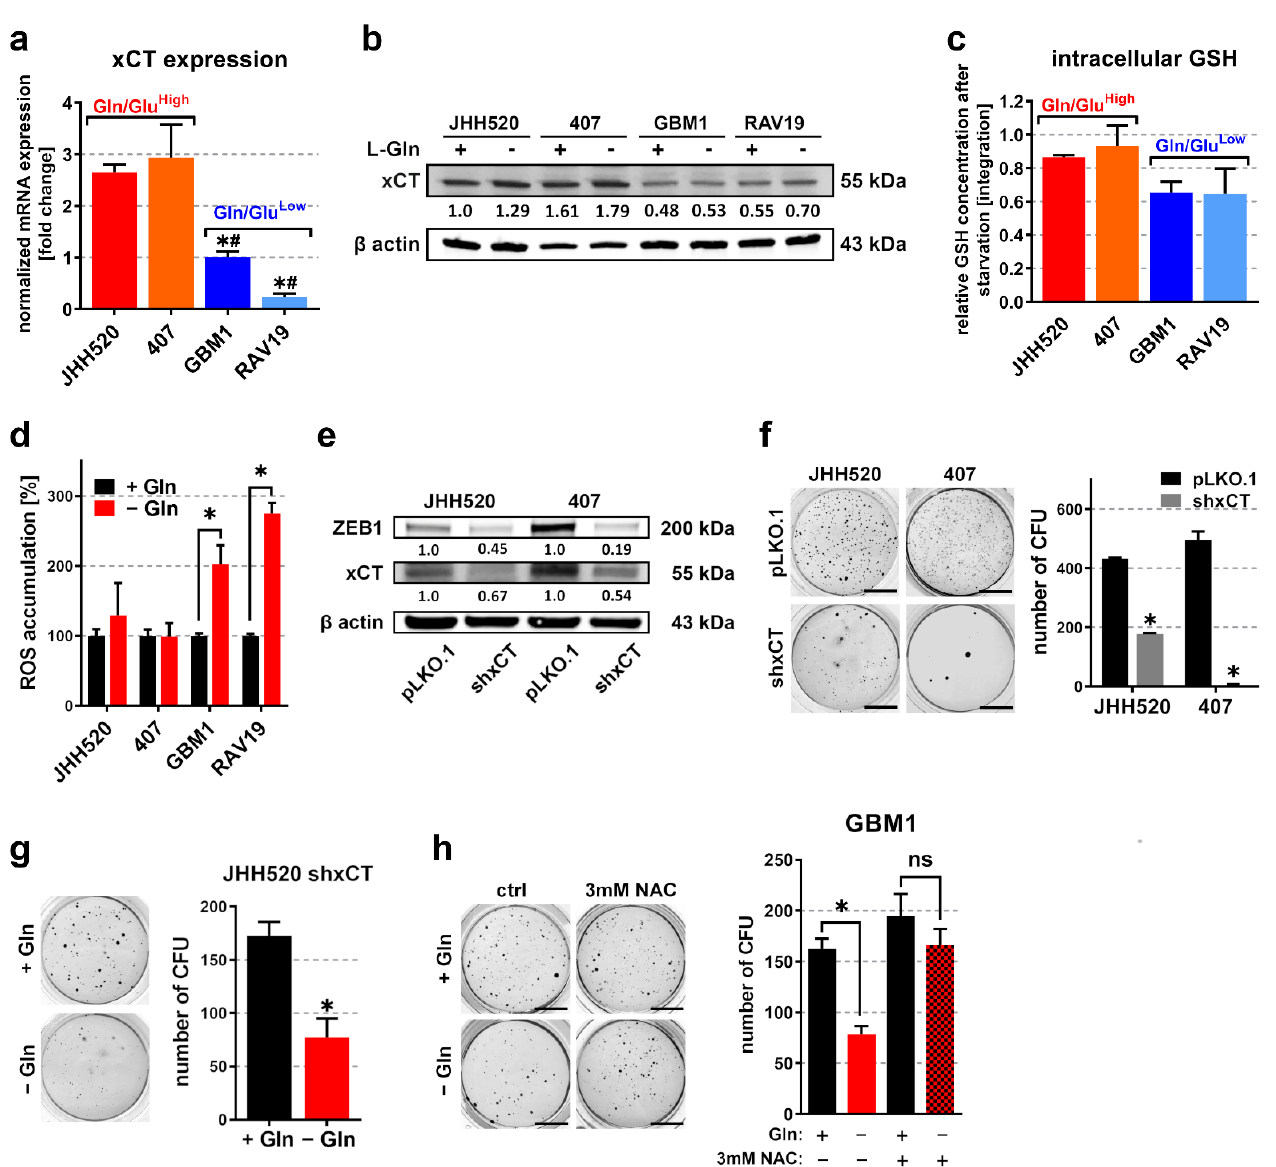
Figure 3. xCT-dependent ROS clearance mediates starvation resistance. Both mRNA ( a ) and protein ( b ) expression of the glutamate/cystine antiporter xCT were elevated in GSCs with high Gln/Glu ratios (JHH520 and 407) (loading control = β actin) ( n = 3, significance was calculated with a one-way ANOVA, * significantly decreased ( p < 0.05) compared to JHH520, # significantly decreased ( p < 0.05) compared to 407). ( c ) Relative GSH concentrations of L-Gln-starved cells (compared to controls in full medium) assessed with 1 H-NMR spectroscopy of metabolic extracts ( n = 3, significance calculated with one-way ANOVA). ( d ) ROS accumulation in L-Gln-starved and control cells measured by means of DCF fluorescence intensity ( n ≥ 3). ( e ) Immunoblotting verification of shRNA-based xCT knockdown and ZEB1 expression in shxCT and pLKO.1 (control) cells (loading control = β actin). ( f ) Soft agar colony formation in shxCT and pLKO.1 (control) cells ( n = 3). ( g ) Soft agar colony formation in JHH shxCT cells cultured in the presence or absence of L-Gln ( n = 3). ( h ) Soft agar colony formation in GBM1 cells starved for L-Gln in either the presence or absence of 3 mM NAC. For all soft agar assays, representative pictures of NBT-stained colonies and quantifications of three assays are shown ( n = 3, scale bar equals 1 cm). For all assays, the data are presented as mean ± SD. Significance was calculated with a one-sided t -test if not specified elsewhere, * p < 0.05. Abbreviations: ctrl, control; CFU, colony-forming units; Gln, glutamine; GSH, glutathione; NAC, N-acetylcysteine; n.s., not significant; ROS, reactive oxygen species. Supplementary Figure 2 (S2) corresponds to Figure 3b, Supplementary Figure 3 (S3) corresponds to Figure